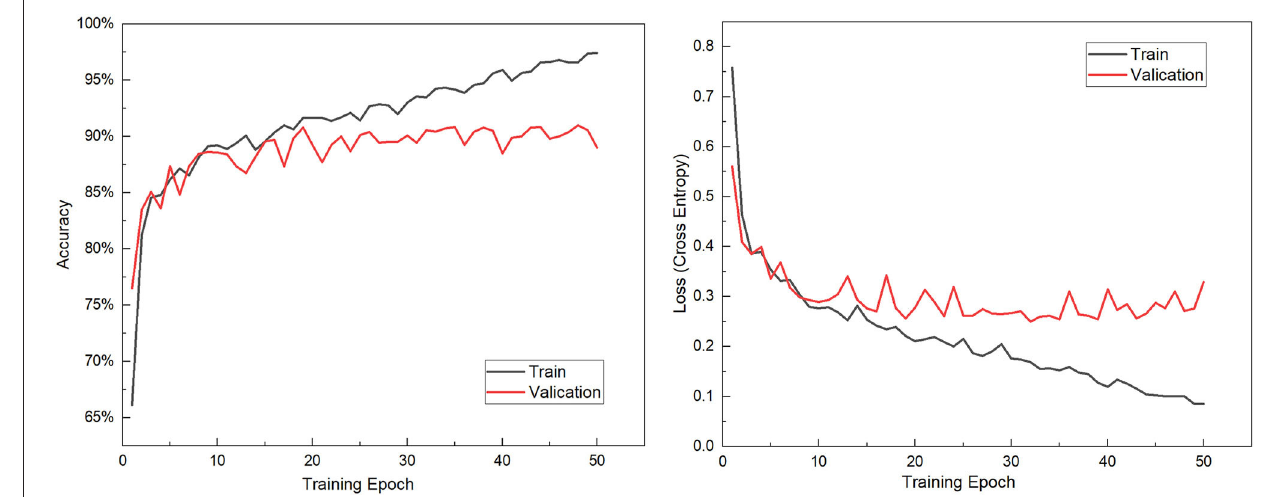
FIGURE 7 | The accuracy and loss variance during the training epochs.